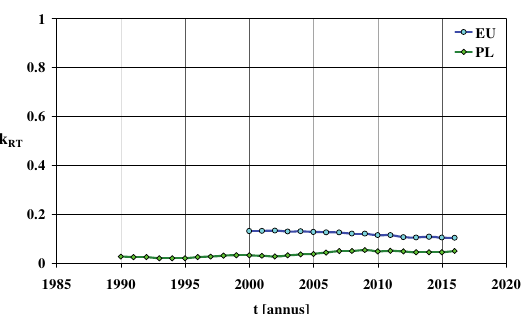
Fig. 17. Share of annual emission from motor vehicles comparing to the total annual emission for particulate matter PM10: in Poland – PL and in